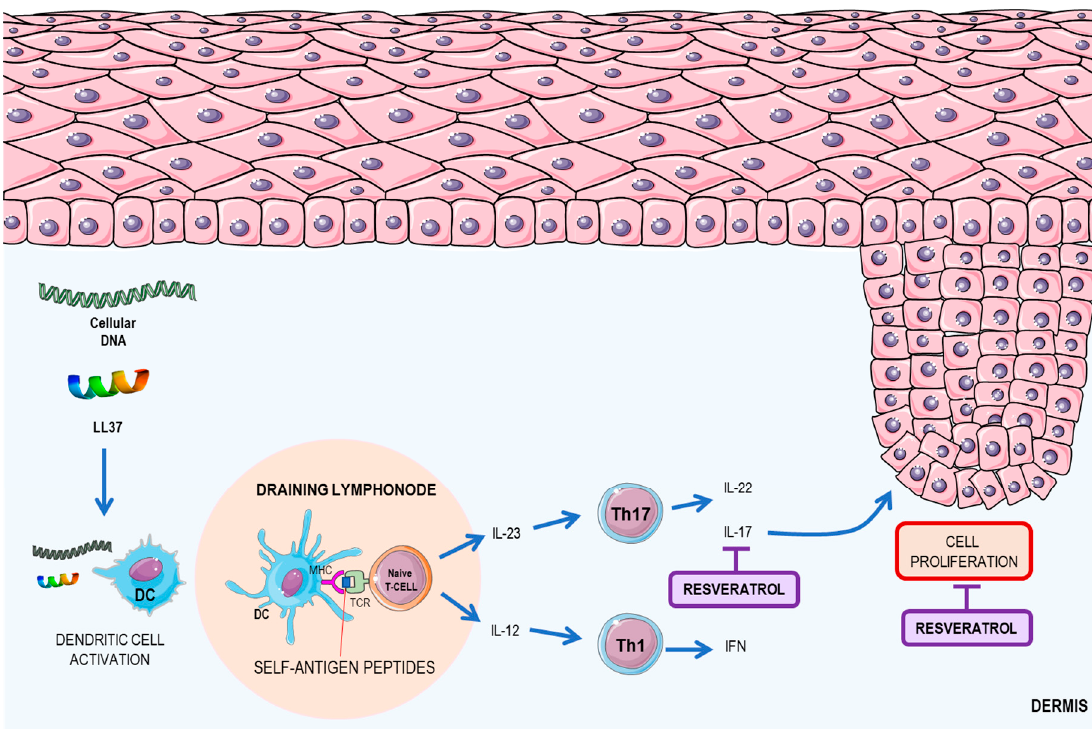
Figure 4. Psoriasis disease mechanism and resveratrol role. Psoriasis begins with the release of cathelicidin peptide (LL37) and fragments of DNA, forming an immunocomplex that activates resident DC cells. These cells activate T lymphocytes primarily through the release of IL-23, promoting differentiation into Th17. IL-16 promotes differentiation into Th1. These cells produce three major cytokines—IL-17, IL-22 (produced by Th17), and IFN (produced by Th1)—that promote the proliferation of keratinocytes. Resveratrol acts in two ways: inhibiting the production of IL-17 and directly inhibiting the proliferation of keratinocytes. DC: dendritic cell; IFN: interferon; IL: interleukin; MHC: major histocompatibility complex; RNS: reactive nitrogen species; ROS: reactive oxygen species; TCR: T-cell receptor. This figure used elements from Servier Medical Art (www.servier.com).